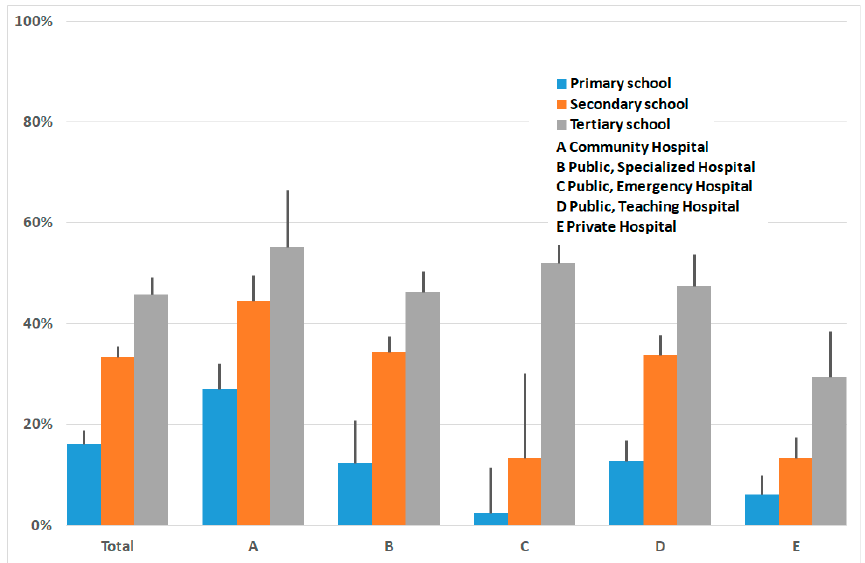
Figure 5. Percentage of women who had attended birth preparation courses, by education level, overall and in various hospital settings.